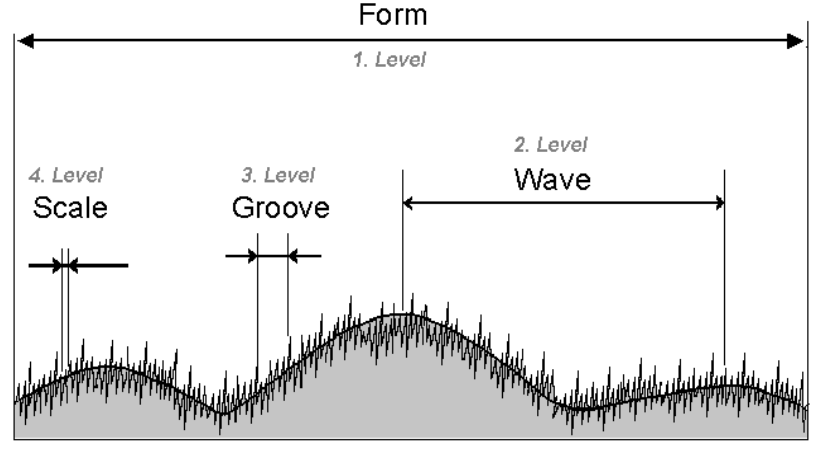
Figure 7. Graphic representation of the inhomogeneities of fine parameters up to four levels of a topographic profile according to DIN 4760.